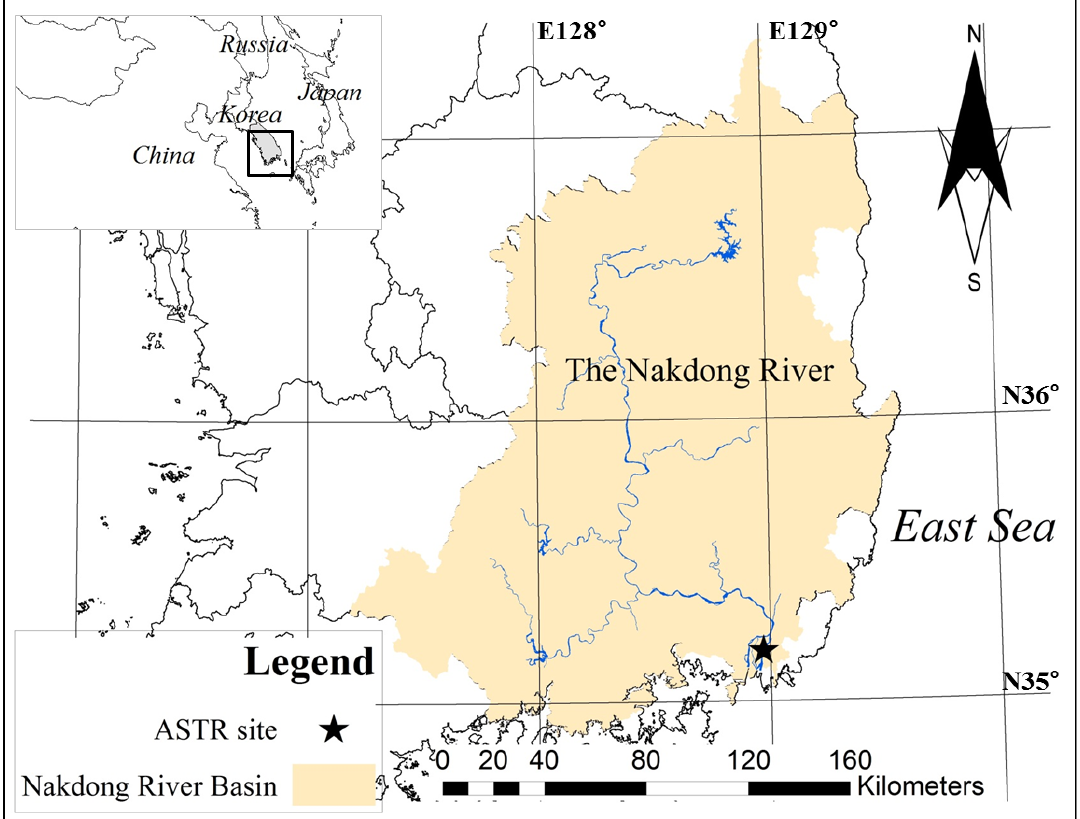
Figure 3. Study area (the Nakdong River Basin).